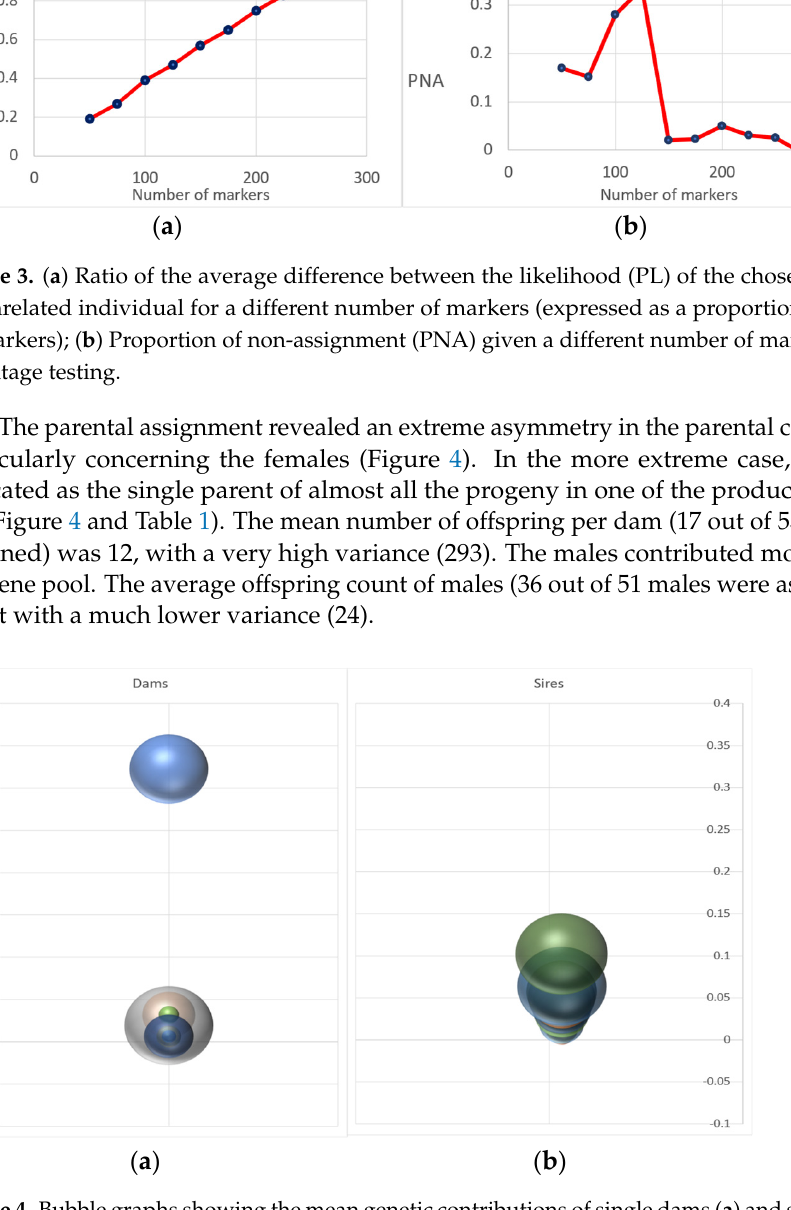
Figure 2. Histogram of the likelihood difference between the chosen candidate (sires or dams) and unrelated sires or dams for each progeny evaluated using all markers included in the panel (272 SNPs).